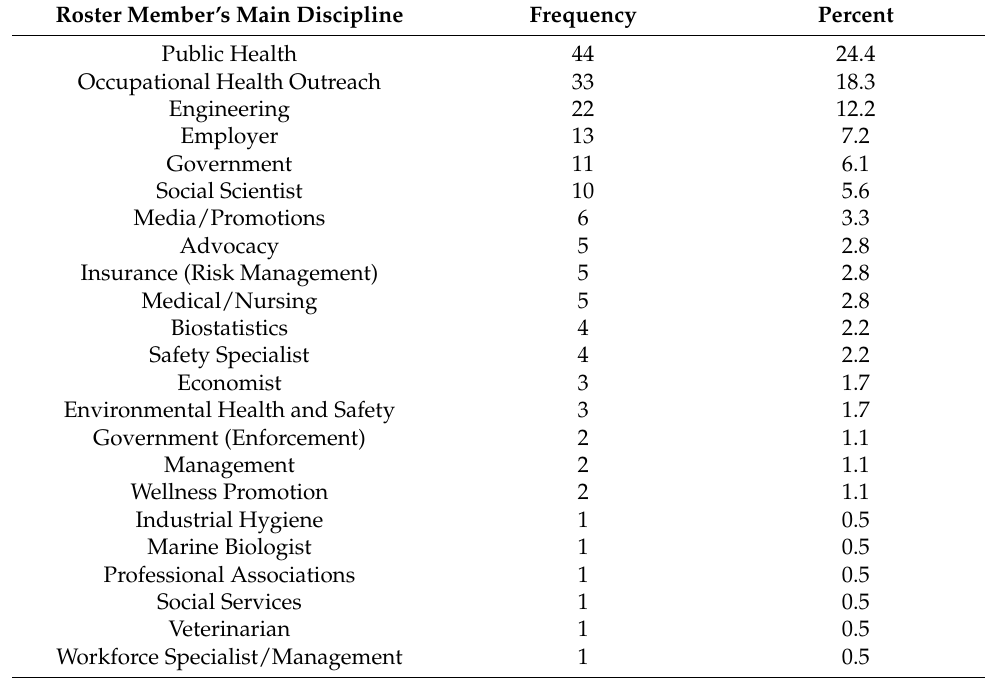
Table 3. Distribution of disciplines combined across ten years of SNA surveys, 2011–2020 ( n = 180 individual roster